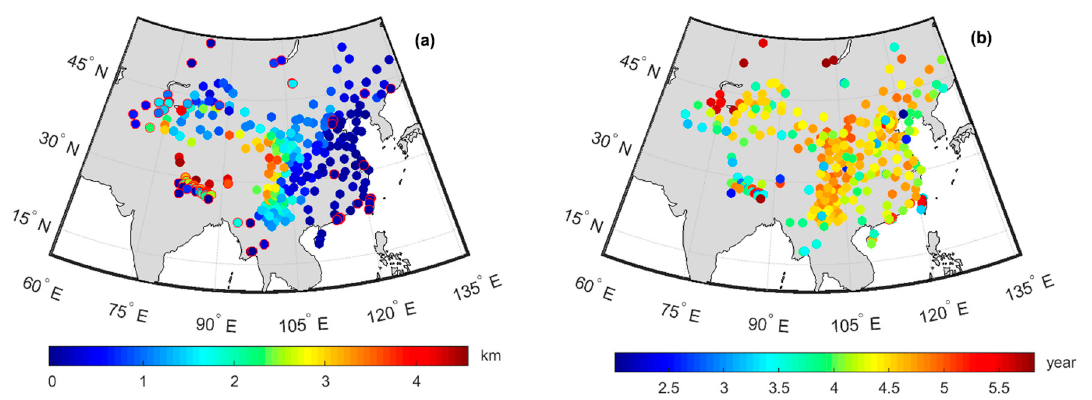
Figure 1. ( a ) Distribution of sites used and ( b ) the valid days of each site. The non-Crustal Movement Observation Network of China (CMONOC) site in panel ( a ) are marked with red edge, the color bar in ( a ) shows the site height in km.